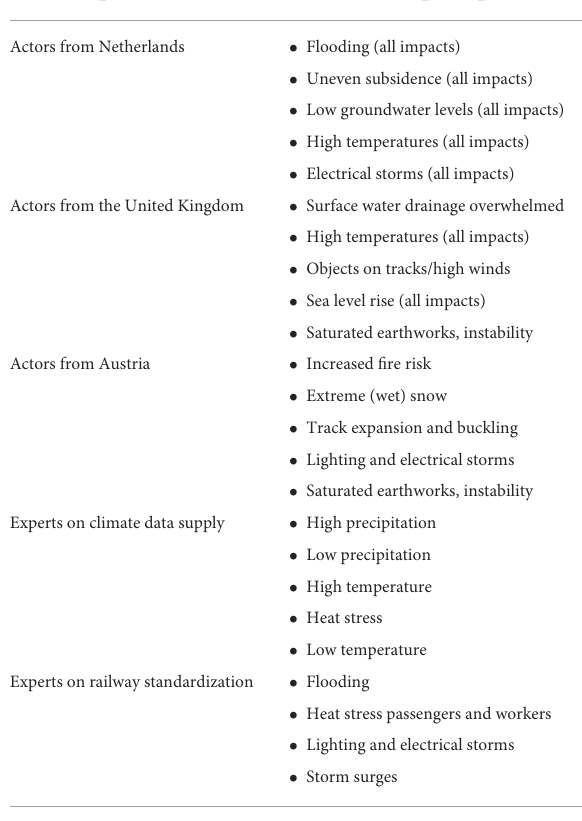
TABLE 2 Prioritized climate change impacts/parameters for rail standards.